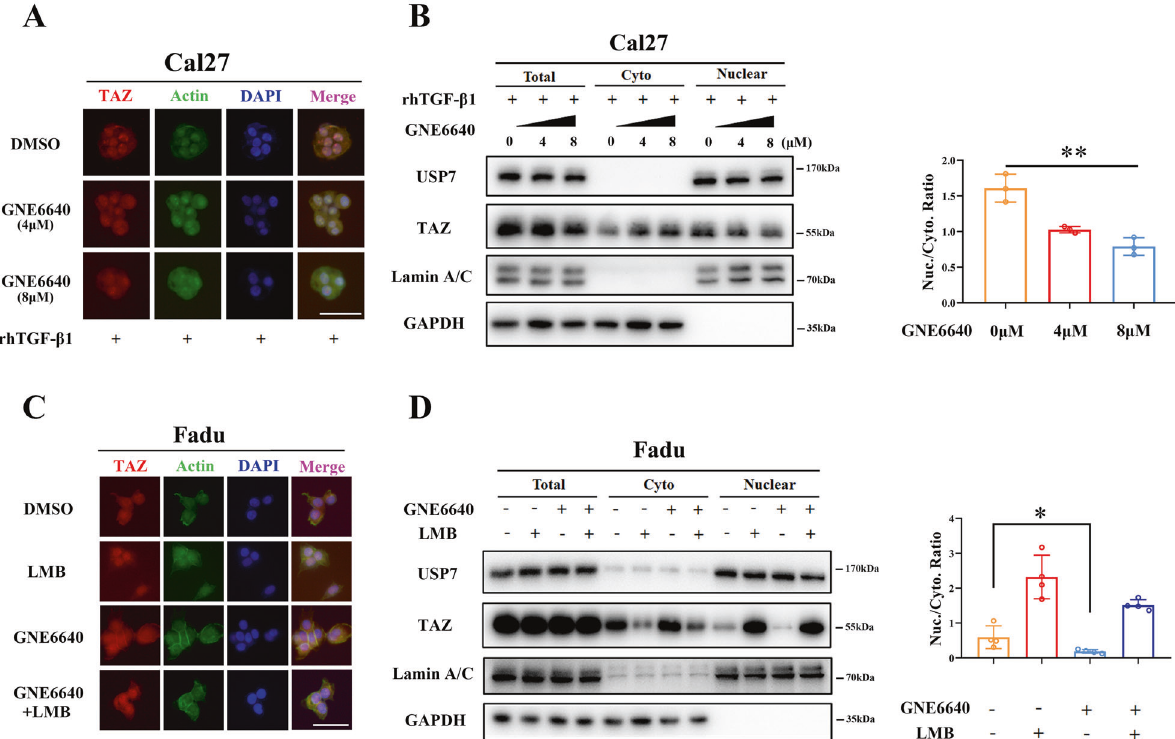
Fig. 6 USP7 facilitates TAZ nuclear retention. A Pharmacological inhibition of USP7 by GNE6640 signi fi cantly reduced nuclear accumulation in an rhTGF- β 1-induced TAZ nuclear relocation cell model. Cal27 cells were pretreated rhTGF- β 1 (10 ng/ml, 6 h) and then exposed to indicated dose of GNE6640 (0, 4, 8 μ M) for another 6 h. TAZ subcellular location (Cy3, red) were determined by immuno fl uorescence. Nucleus was counterstained with DAPI (blue), and cytoskeleton was visualized with Actin Tracker (FITC, green). Scale bar: 50 μ m. B The protein abundance of TAZ in cytoplasmic and nuclear fractions was measured by western blot in Cal27 cells treated with rhTGF- β 1 (10 ng/ml, 6 h) and GNE6640 (0, 4, 8 μ M) for another 6 h. Lamin A/C and GAPDH were utilized as nuclear or cytoplasmic control, respectively. Quanti fi cation of results was shown in the right panel. C TAZ nuclear export induced GNE6640 (8 μ M, 6 h) in Cal27 cells was reversed by Leptomycin B (LMB, 20 ng/ml, 6 h) as gauged by TAZ immuno fl uorescence. Nucleus was counterstained with DAPI (blue), and cytoskeleton was visualized with Actin Tracker (FITC, green). Scale bar: 50 μ m. D The protein abundance of TAZ in cytoplasmic and nuclear fractions was measured by western blot in Cal27 cells treated with and GNE6640 (8 μ M) and/or LMB (20 ng/ml). Quanti fi cation of results was shown in the right panel. Data were presented with representative images from three independent experiments. Student ’ s t test or ANOVA test. * p < 0.05, ** p <